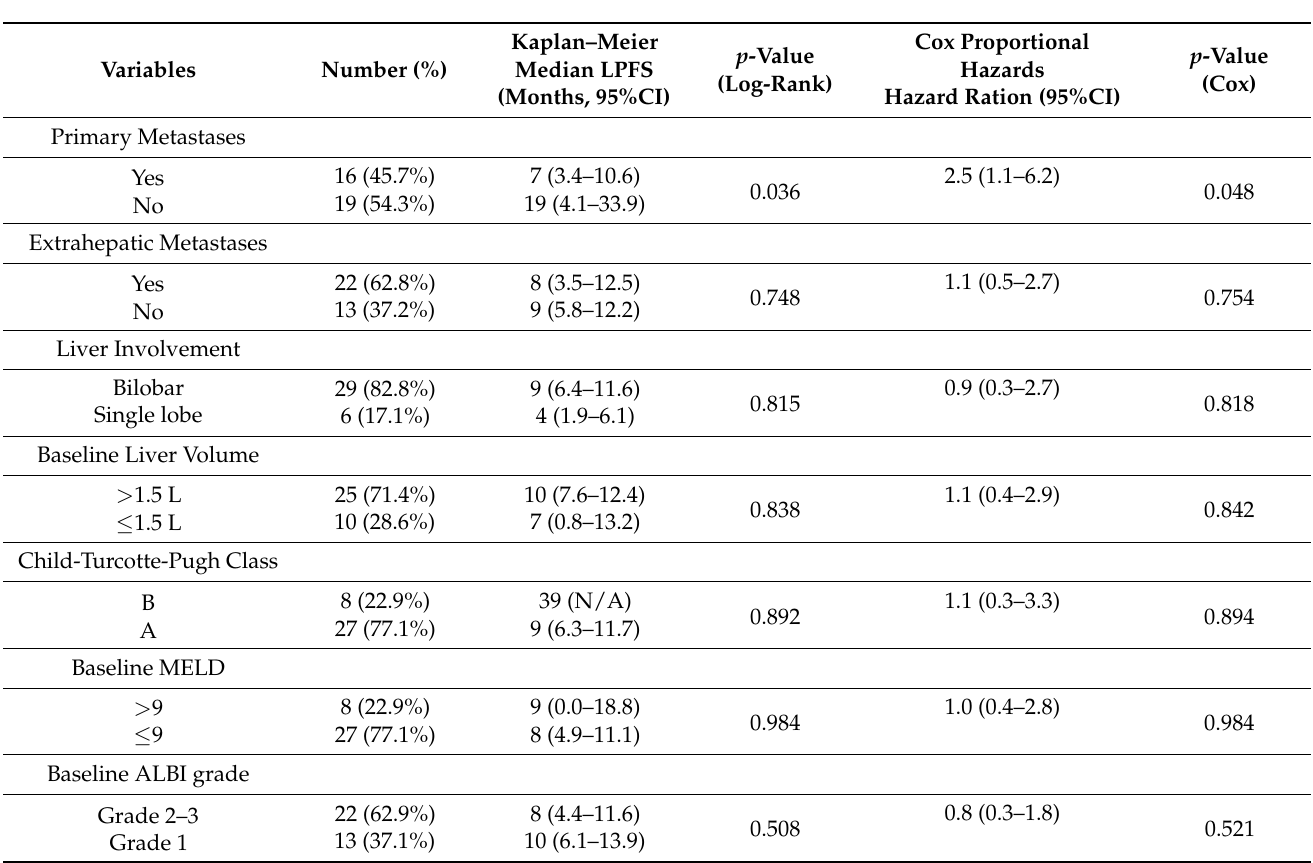
Table 4. Univariate analysis of liver progression-free